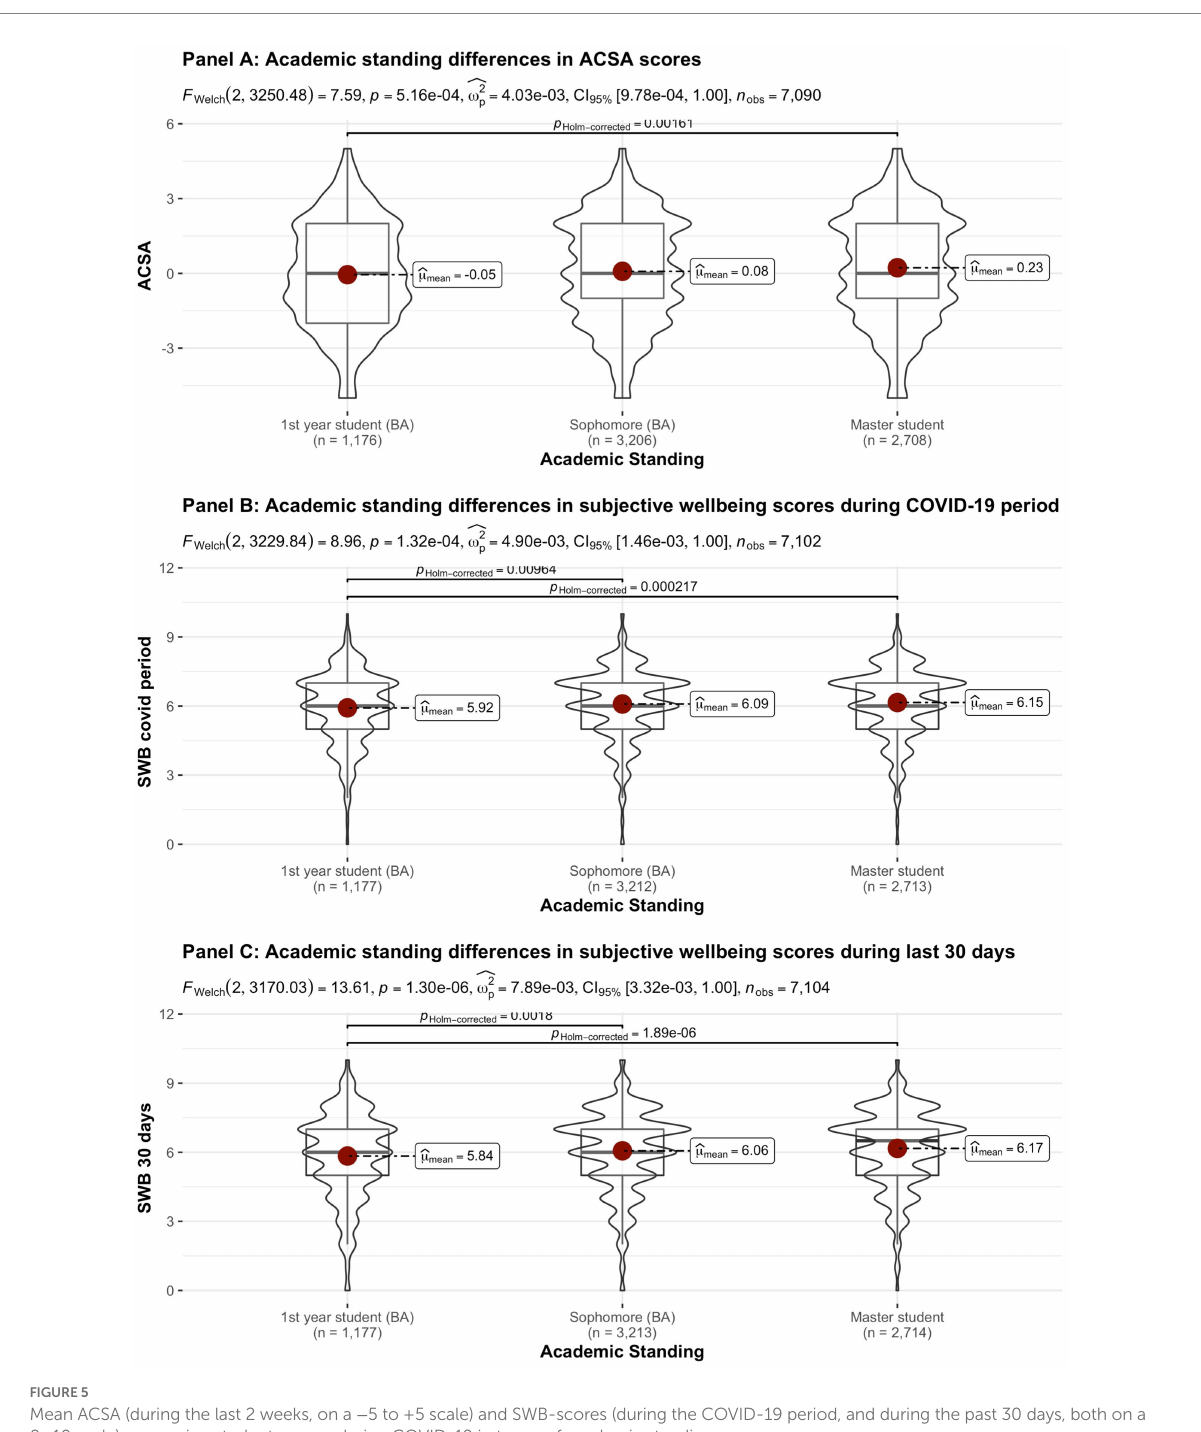
FIGURE 5 Mean ACSA (during the last 2 weeks, on a − 5 to +5 scale) and SWB-scores (during the COVID-19 period, and during the past 30 days, both on a 0–10 scale) comparing student groups during COVID-19 in terms of academic